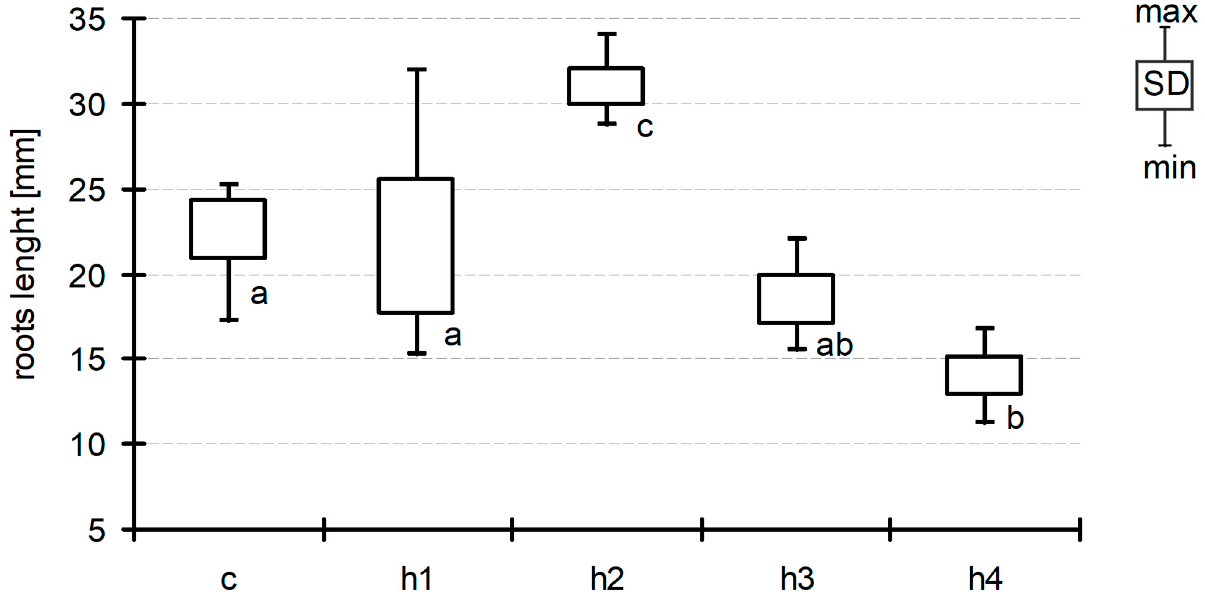
Figure 3. The length of roots of Lemna minor at the end of the experiment (means with the same letters did not differ significantly; post hoc Duncan’s test at p < 0.05).